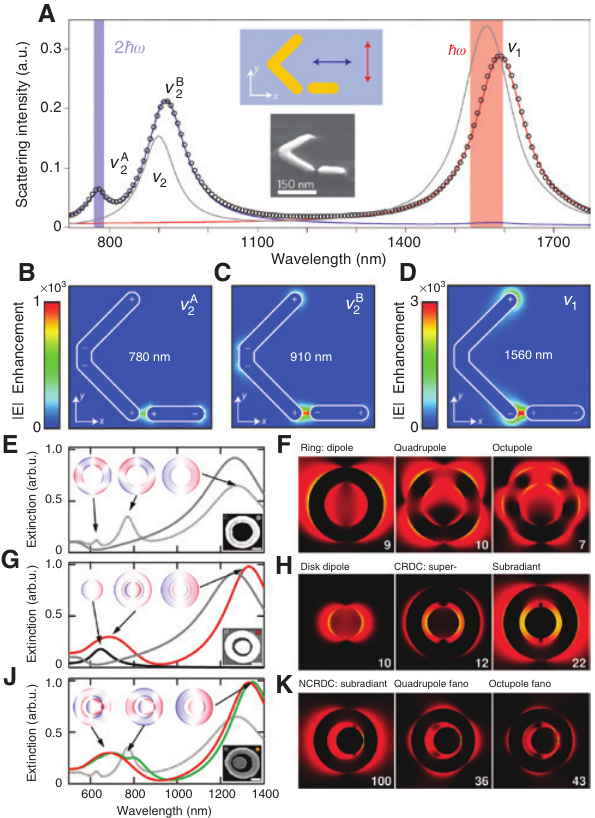
Figure 4: Two examples of multiresonant plasmonic systems based on the optical coupling between localized plasmonic modes in in-plane dimer nanostructures. (A) A plasmonic dimer structure and its far-field scattering spectra [23]. (B–D) The near-field distribution maps of electric field